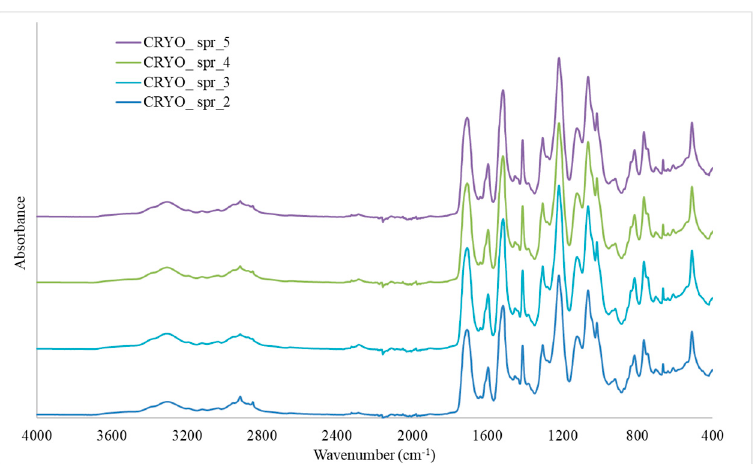
Figure 7. FTIR spectra of rigid PUR foam compositions.